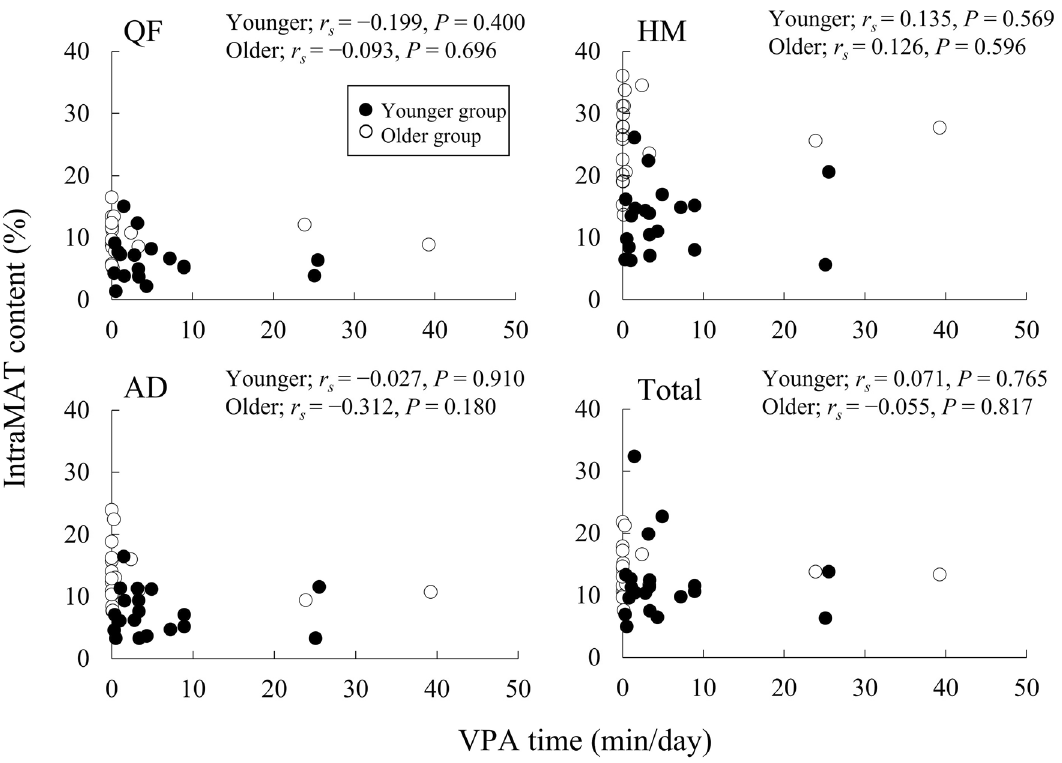
Figure 3. Correlation between vigorous-intensity physical activity (VPA) times and intramuscular adipose tissue (IntraMAT) content in younger and older men. QF quadriceps femoris, AD hip adductors, and HM